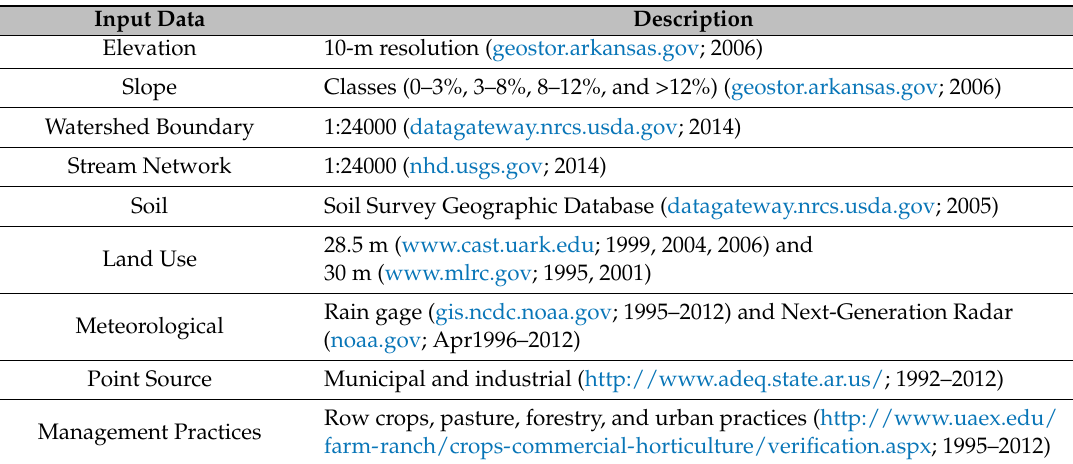
Table 1. Model inputs for the L’Anguille River Watershed.